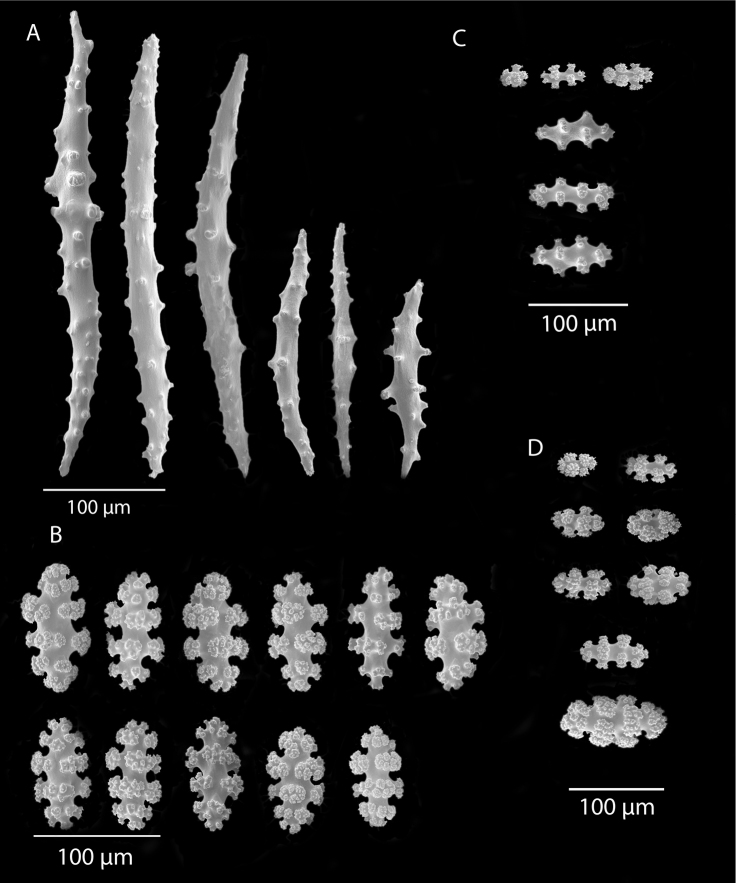
Leptogorgiadiffusa, SBMNH 423090, SEM image. A Anthocodial sclerites; some were surprisingly and unexpectedly long B–D Coenenchymal spindles. Images, for the most part, match those shown in Breedy and Guzmán 2007 (figs 23, 24).